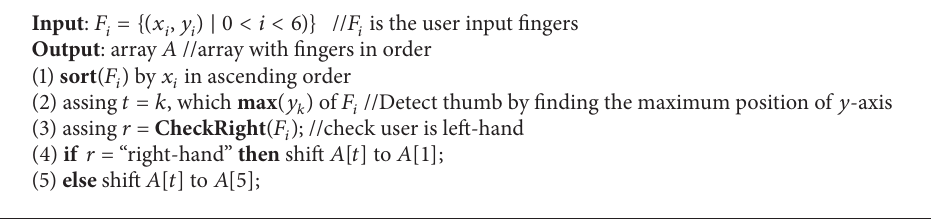
Algorithm 2: Hand natural pose restoration.